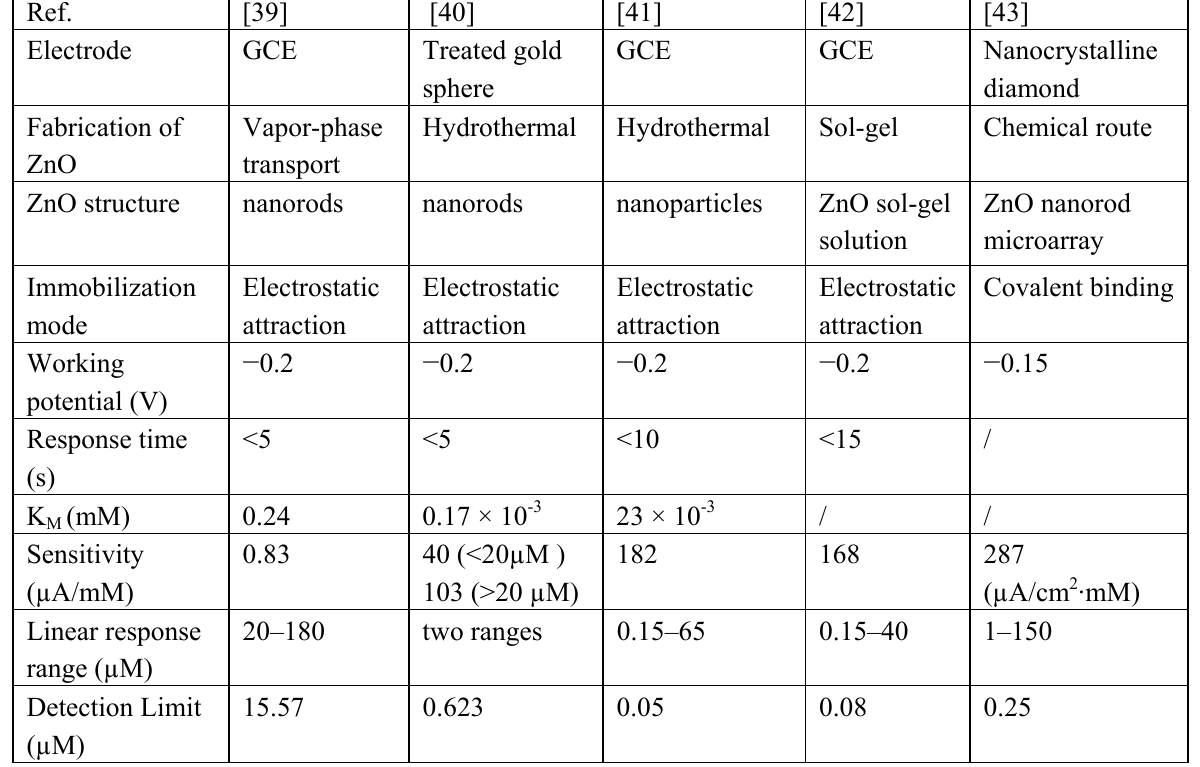
Table 3. ZnO-based electrochemical biosensors for phenol detection (tyrosinase as enzyme) (“/” in the table means the corresponding data is not provided.).